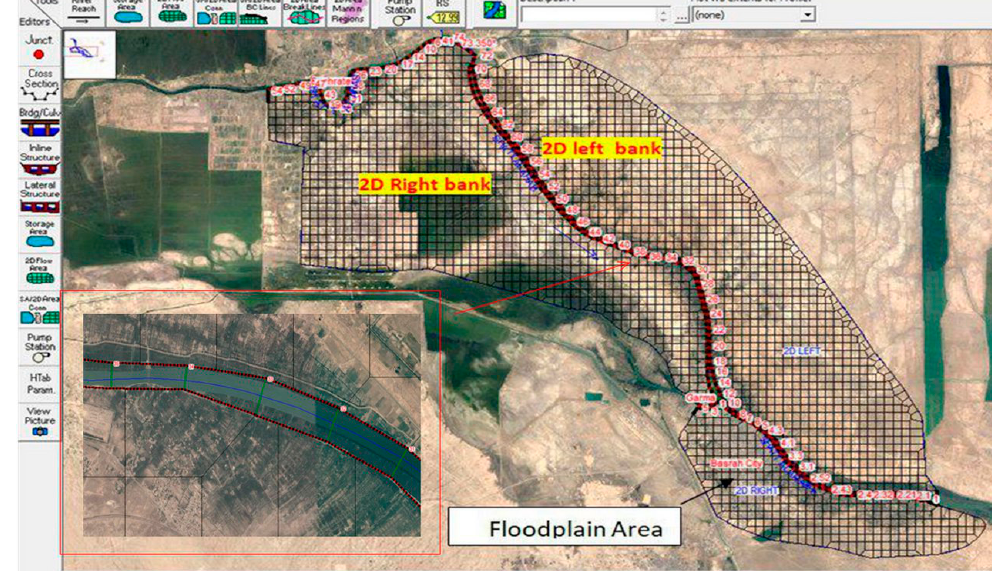
Figure 8. Creating 2D flow-area polygon.